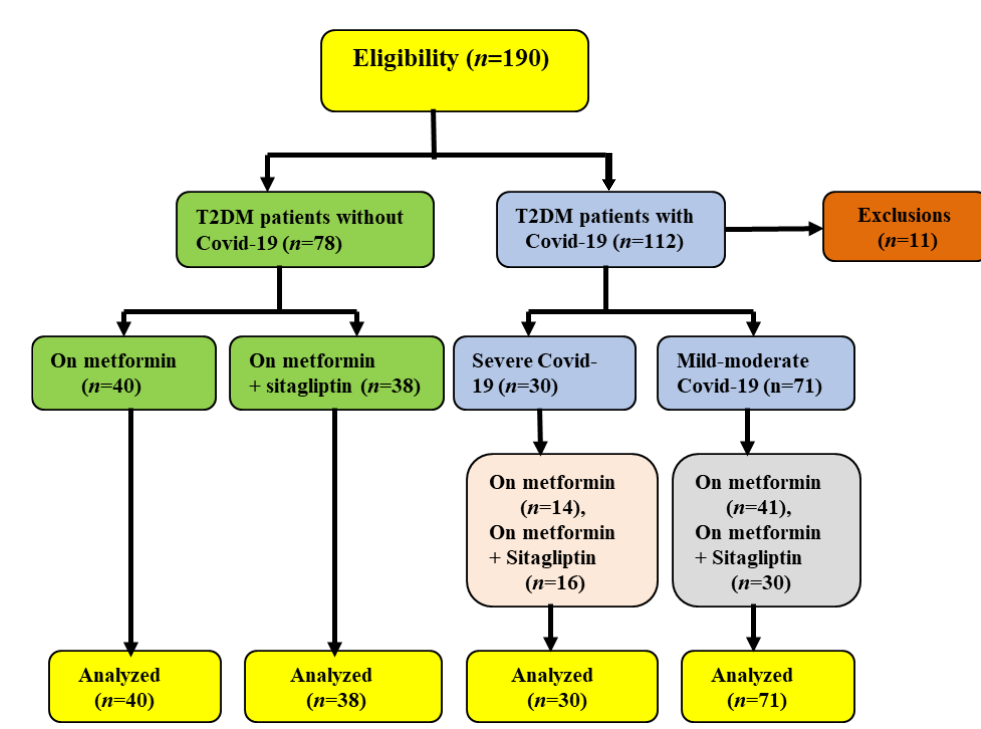
Figure 1. Consort-flow diagram of the current study.